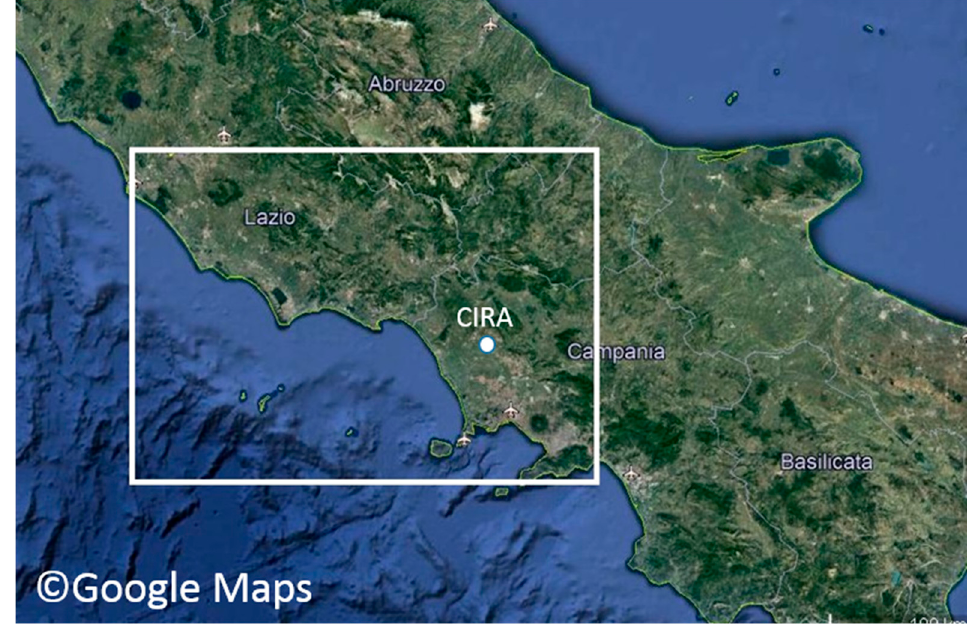
Figure 1. The computational domain considered, including northern Campania and southern Lazio regions. The Italian Aerospace Research Center (CIRA) site is specified.